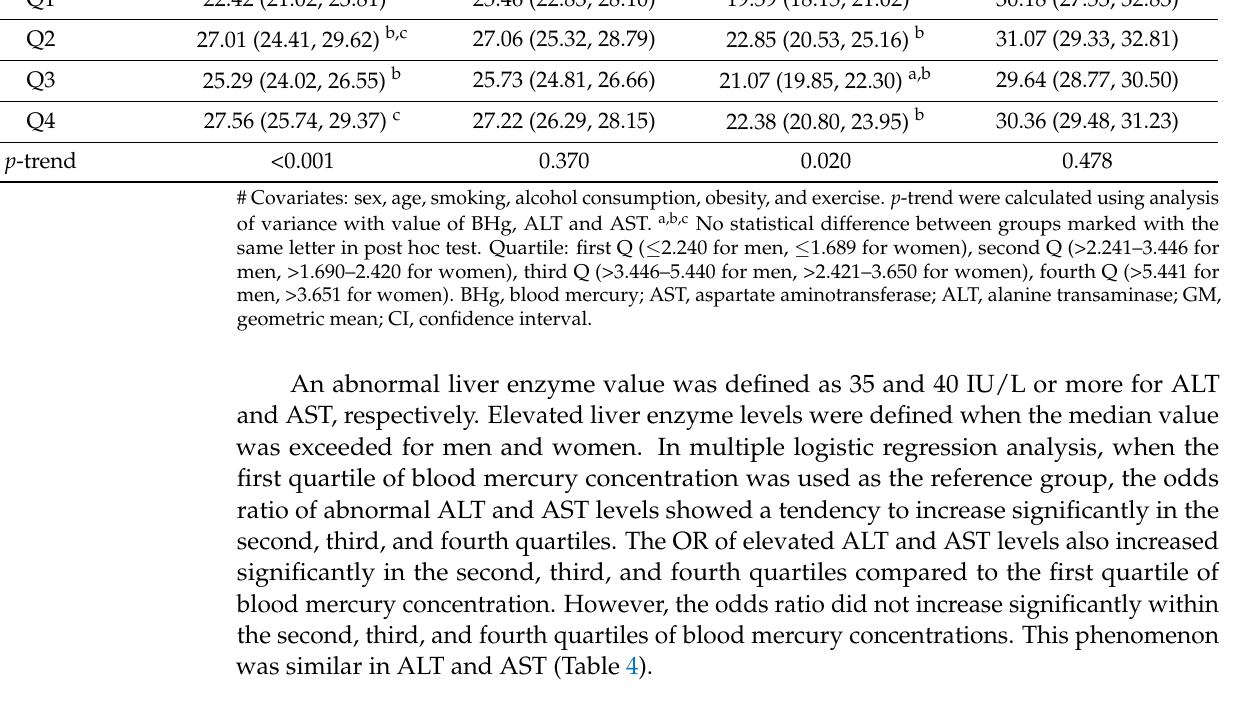
Table 4. Odds ratio and 95% CI of blood mercury ( µ g/L) for abnormal and elevated AST (IU/L) and ALT (IU/L) in logistic linear regression analysis before and after adjustment of covariates